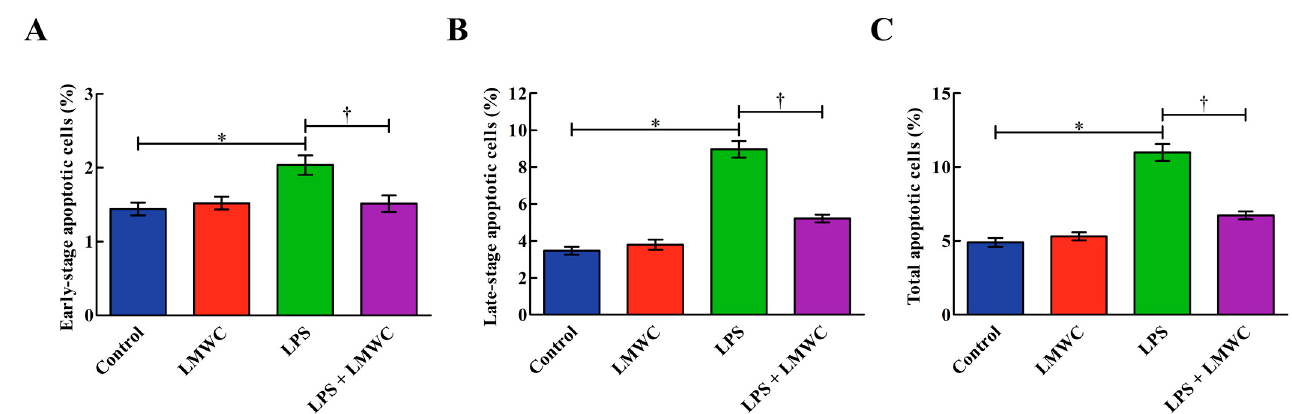
Figure 5. Effects of LMWC on apoptosis in LPS-treated IPEC-J2 cells. ( A ) Early-stage apoptotic cells. ( B ) Late-stage apoptotic cells. ( C ) Total apoptotic cells. Cells were pretreated with LMWC (400 µ g/mL) for 2 h, followed by cotreatment with LPS (5 µ g/mL) for another 6 h. Data are presented as the mean ± standard error ( n = 4). * Means significant difference compared with the control group ( p < 0.05). † Means significant difference compared with the LPS group ( p < 0.05).